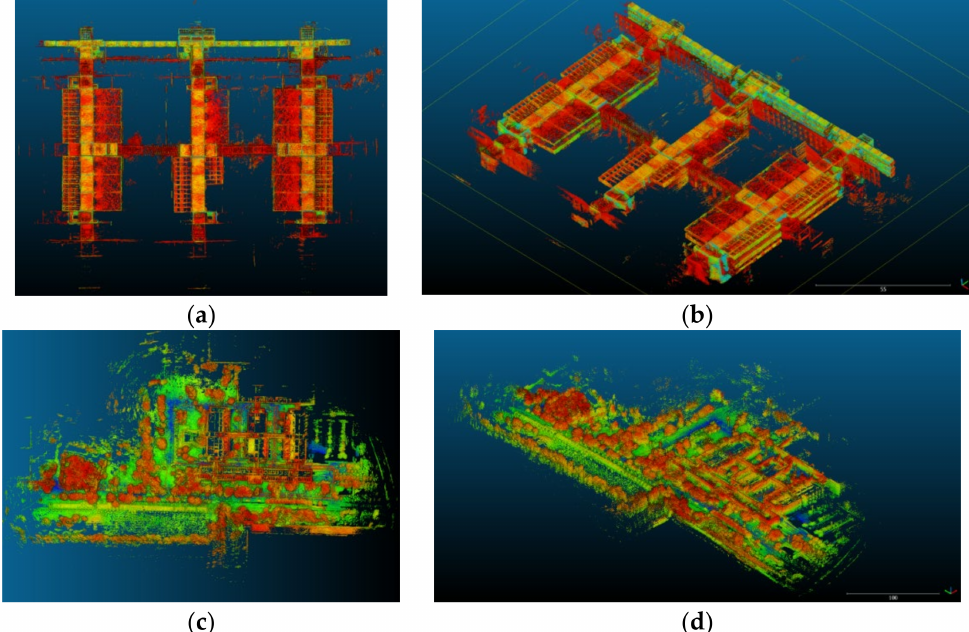
Figure 7. Corrected final 3D Maps: ( a ) top view of the indoor environment; ( b ) perspective view of the indoor environment; ( c ) top view of the outdoor environment; ( d ) perspective view of the outdoor environment.